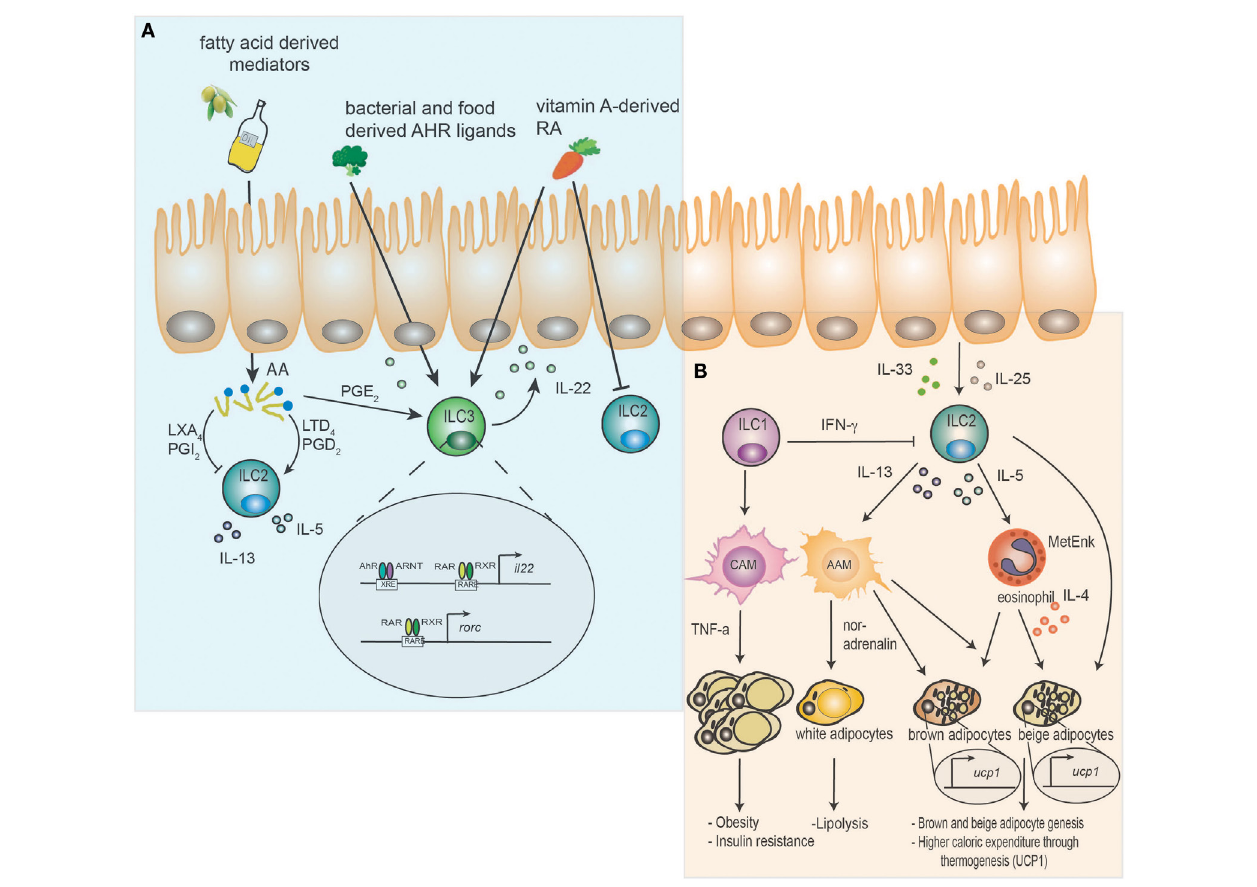
FigUre 1 | Dual function of innate lymphoid cells (ILC) as relays of dietary components and host metabolism. (A) Dietary components such as aryl hydrocarbon receptor (AhR) ligands and vitamin A-derived retinoic acid (RA) are sensed by ILC. AhR/ARNT signaling promotes interleukin (IL)-22 release from ILC3 by directly binding to xenobiotic response elements in the il22 locus. Vitamin A-derived RA additionally enhances IL-22 secretion by binding of retinoic acid receptor (RAR) and retinoic X receptor (RXR) to retinoic acid response elements on the DNA and induces rorc expression. Furthermore, retinoic acid (RA) can directly inhibit ILC2. Essential plant-derived fatty acids (FA) are converted into arachidonic acid (AA) in the host and further metabolized into prostaglandins (PGs), leukotrienes (LTs), and lipoxins (LXs). Prostaglandin D 2 (PGD 2 ) and leukotriene D 4 (LTD 4 ) activate ILC2 and support expression of the cytokines IL-5 and IL-13. In contrast prostaglandin I 2 (PGI 2 ) and lipoxin A 4 (LXA 4 ) inhibit the function of ILC2. Prostaglandin E 2 (PGE 2 ) supports the function of ILC3 and IL-22 expression. (B) Epithelial-derived cytokines IL-33 and IL-25 activate ILC2 to release methionine-enkephalin (MetEnk), IL-13 and IL-5, which promote the activation of alternatively activated macrophages (AAM) and eosinophils. IL-4 secreted by eosinophils and AAM enhance brown and beige adipocyte genesis and mediate higher caloric expenditure through induction of uncoupling protein 1 (UCP1). Additionally, AAM may promote lipolysis in white adipocytes via noradrenalin. ILC2 are inhibited by ILC1 derived interferon (IFN)- γ , which drives classically activated macrophages (CAM) and the development of obesity and insulin resistance in a TNF- α -dependent